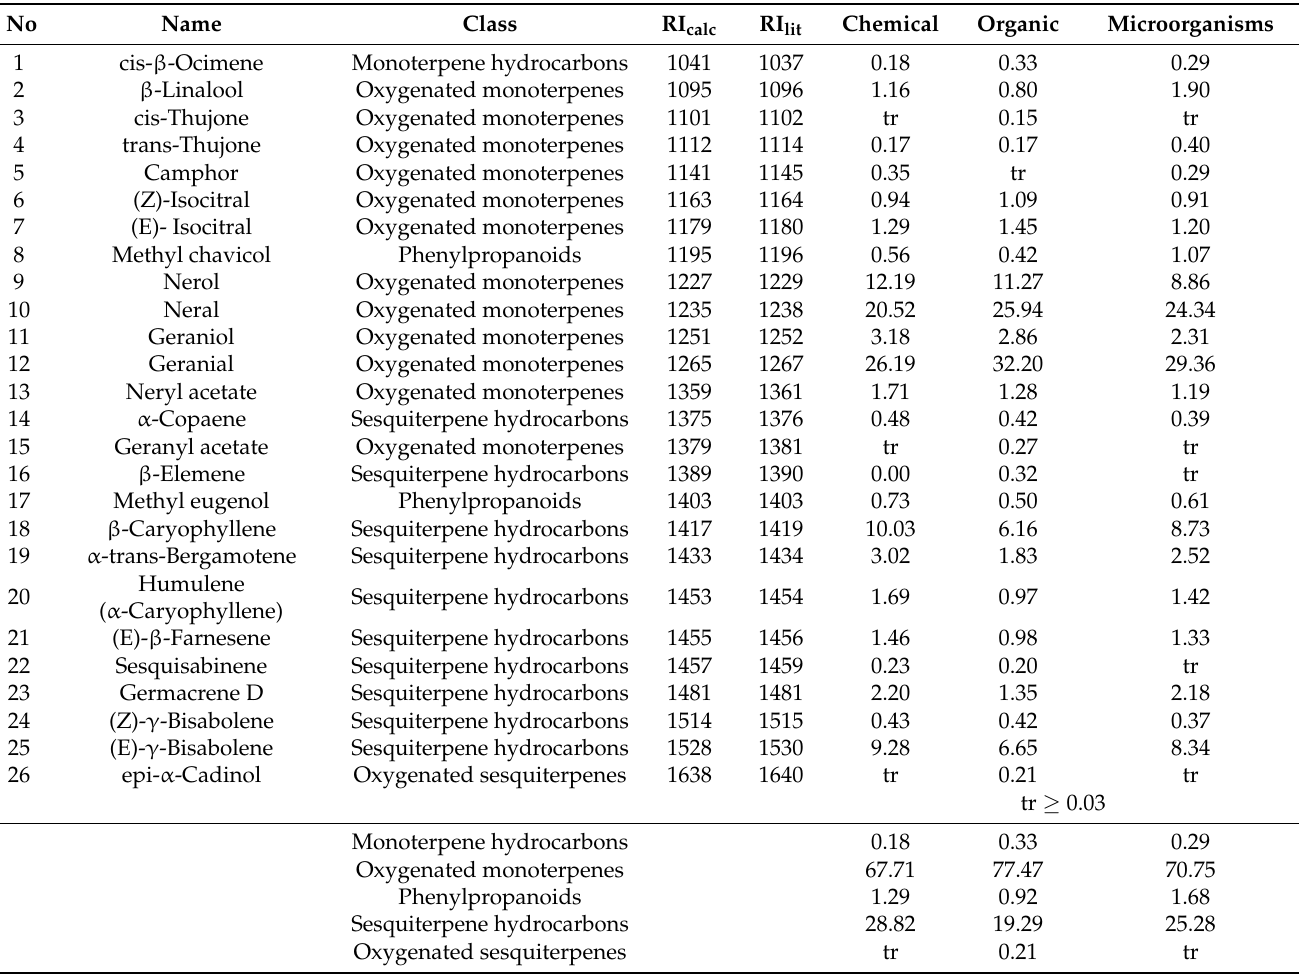
Table 10. Influence of fertilization on essential oil composition of ‘Macedon’